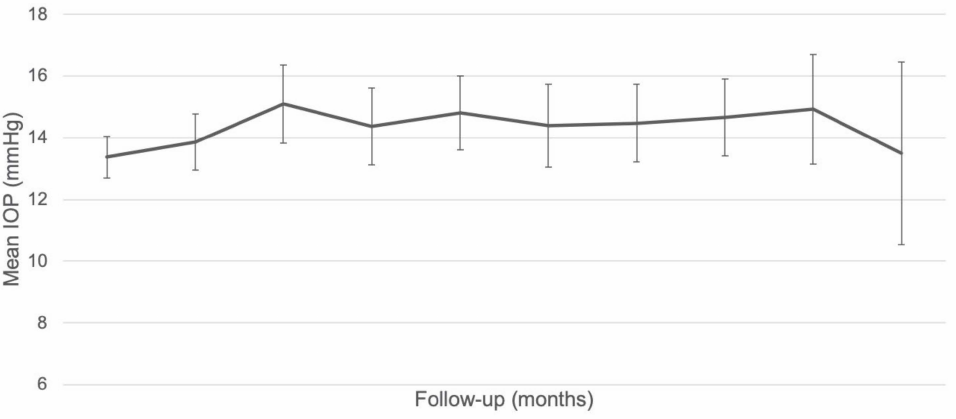
Figure 4. Change in intraocular pressure (IOP) throughout